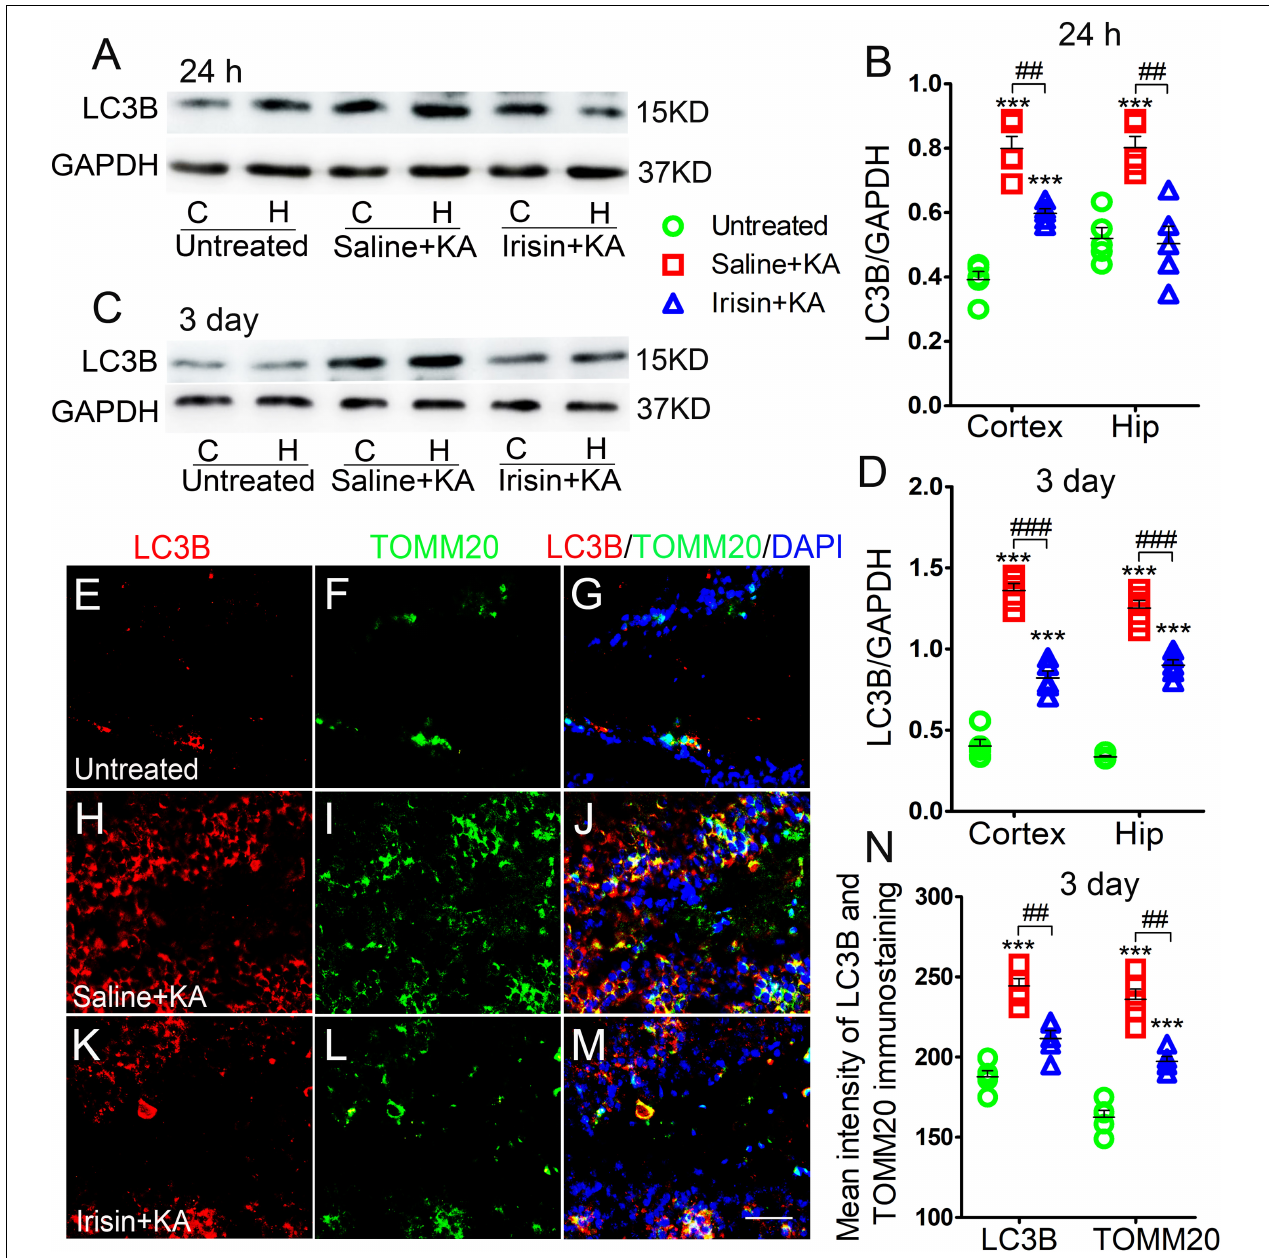
FIGURE 3 | Exogenous irisin treatment reduced the increased mitophagy in rats with KA-induced SE. (A–D) Measurements of LC3B expression in the cortex and hippocampus after irisin administration ( n = 5/group). (E–N) Mean fluorescence intensity of LC3B and TOMM20 immunostaining in the DG ( n = 5/group). LC3B (red), TOMM20 (green), DAPI (blue). Bar = 30 µ m. *** P < 0.001 compared with controls; ## P < 0.01, and ### P < 0.001 compared with each other (One-way ANOVA with Dunnett’s T3 post hoc test). C, cortex; H/Hip, hippocampus; LC3B, microtubule-associated protein light chain 3B; TOMM20, translocase of outer mitochondrial membrane 20; DG, dentate